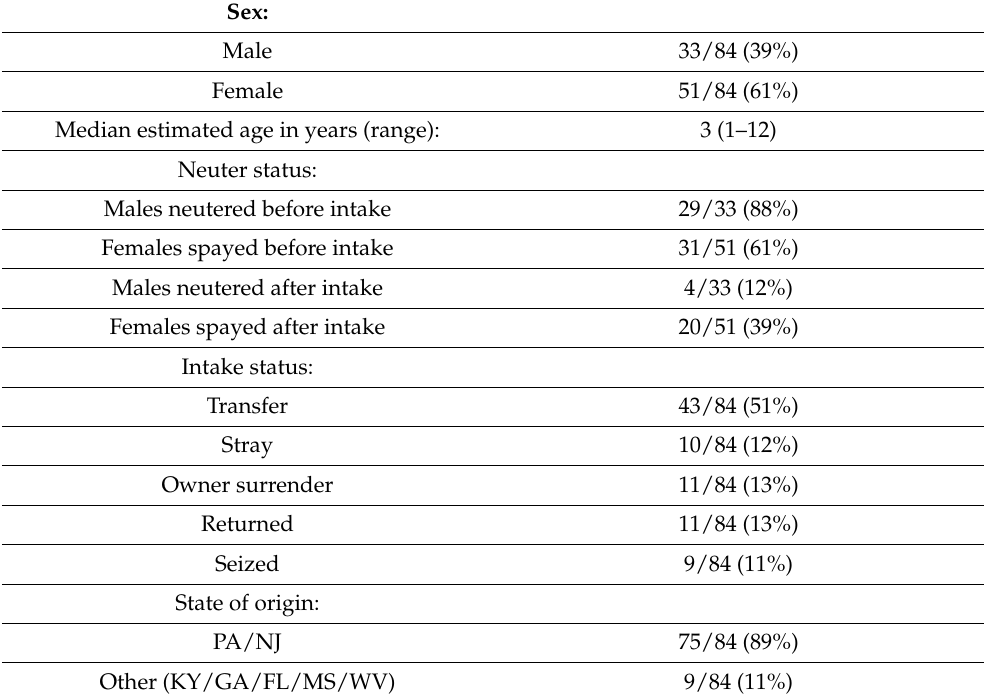
Table 1. Population parameters for the 84 cats included in the study. Sex: Male 33/84 (39%) Female 51/84 (61%) Median estimated age in years (range): 3 (1–12) Neuter status: Males neutered before